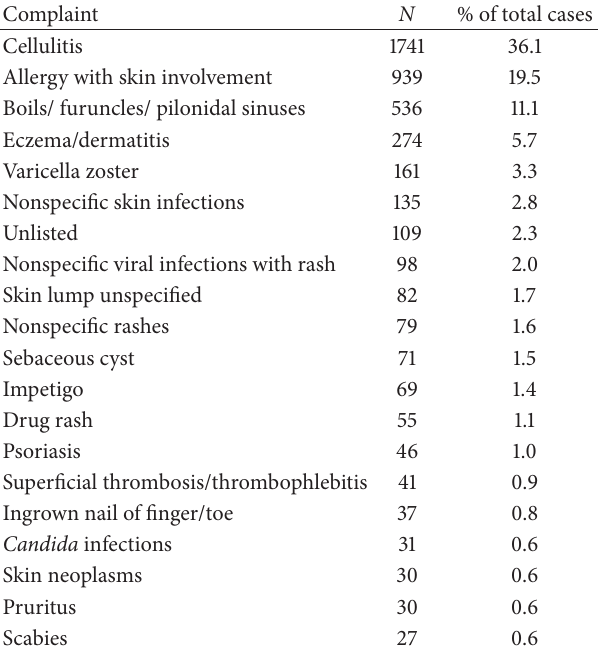
Table 2: Top 20 skin complaints seen at SVHM ED by ICD-10 diagnostic